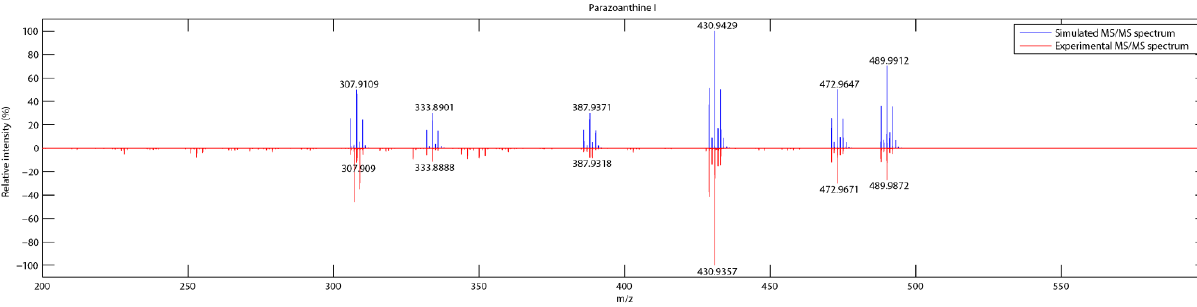
Figure 6. Comparison of simulated and experimental MS/MS spectra of parazoanthine I